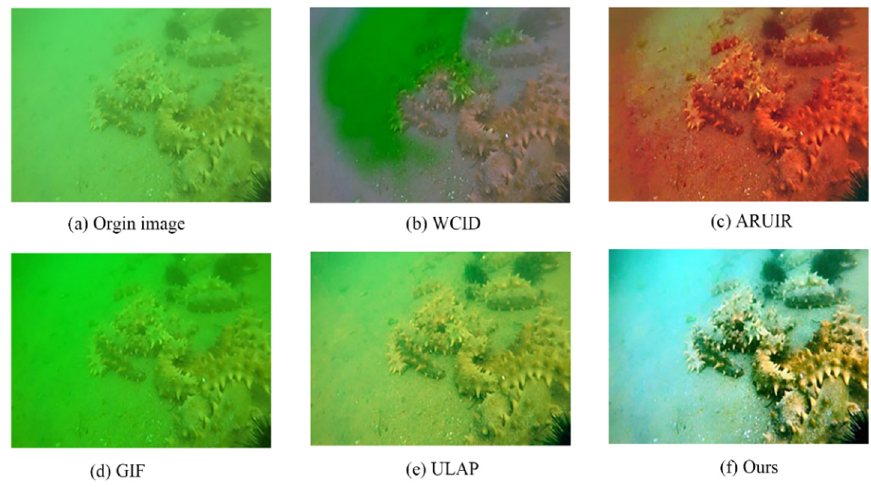
Figure 6. Underwater image enhancement result. ( a ) The origin image. ( b ) The result of WCID; ( c ) the result of ARUIR; ( d ) the result of GIF; ( e ) the result of ULAP; ( f ) the result of ours.